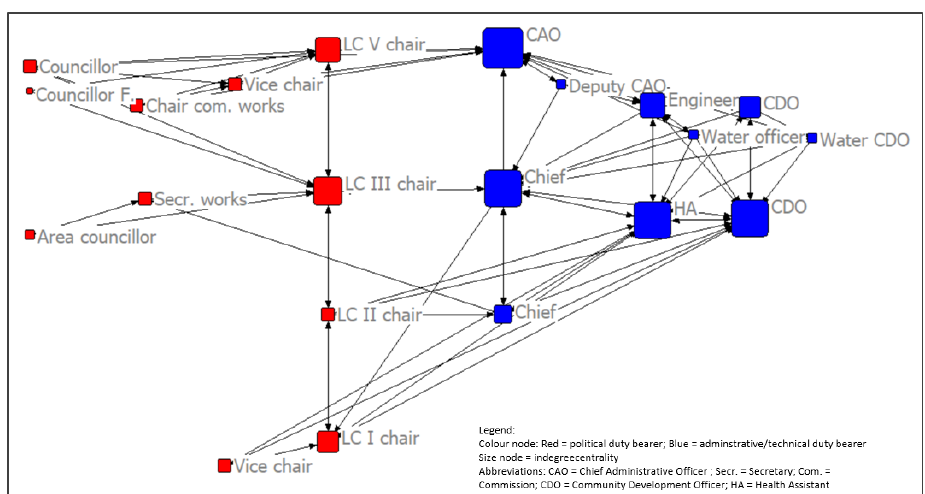
Figure 3b: Theoretical ‘information-sharing’ network